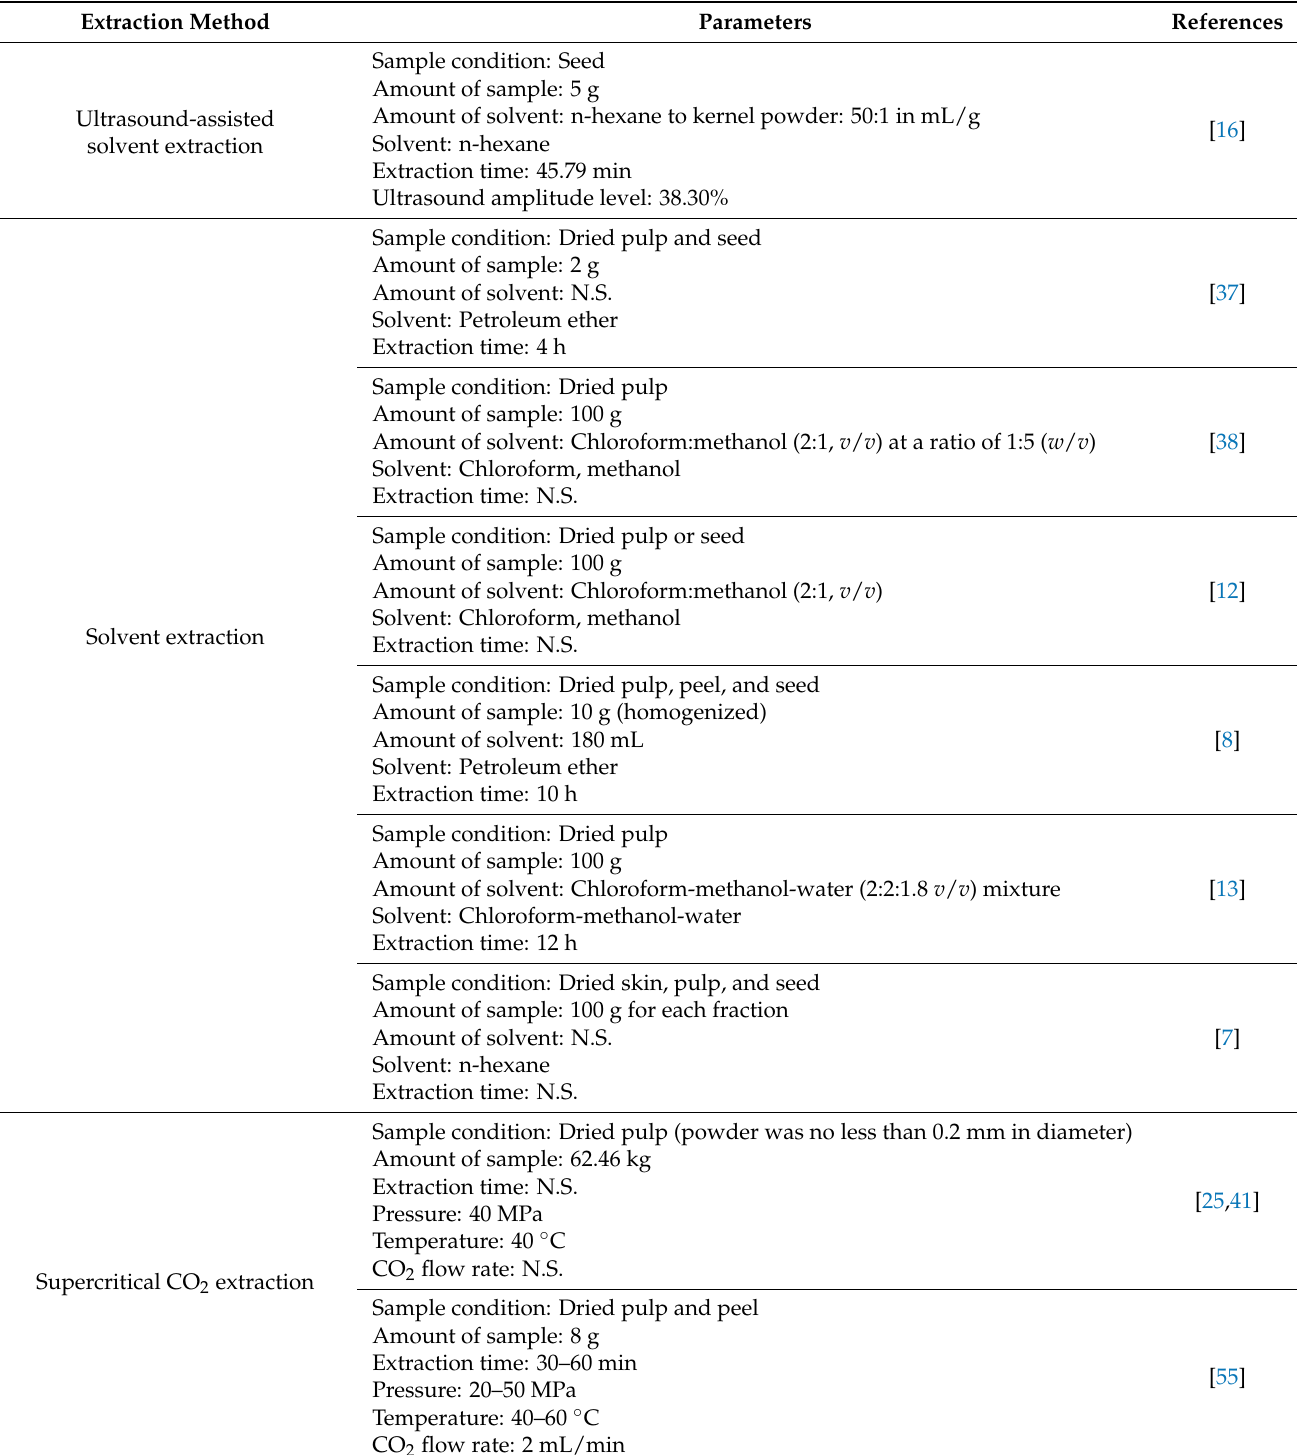
Table 4. Extraction method and parameters for essential dabai